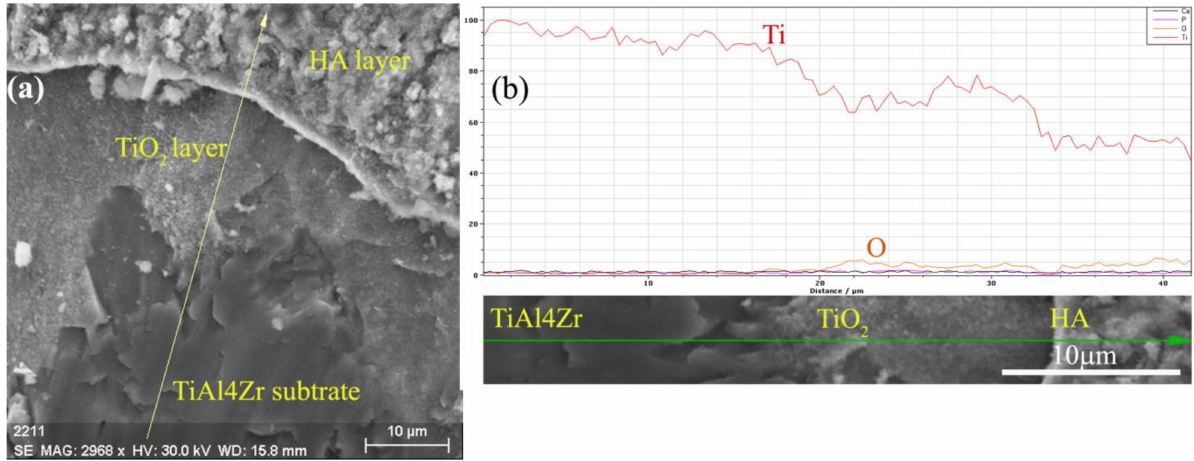
Figure 5. Complex structure identification of HA deposition through line chemical composition mode ( a ) SEM image of analyzed area; ( b ) chemical elements line variations